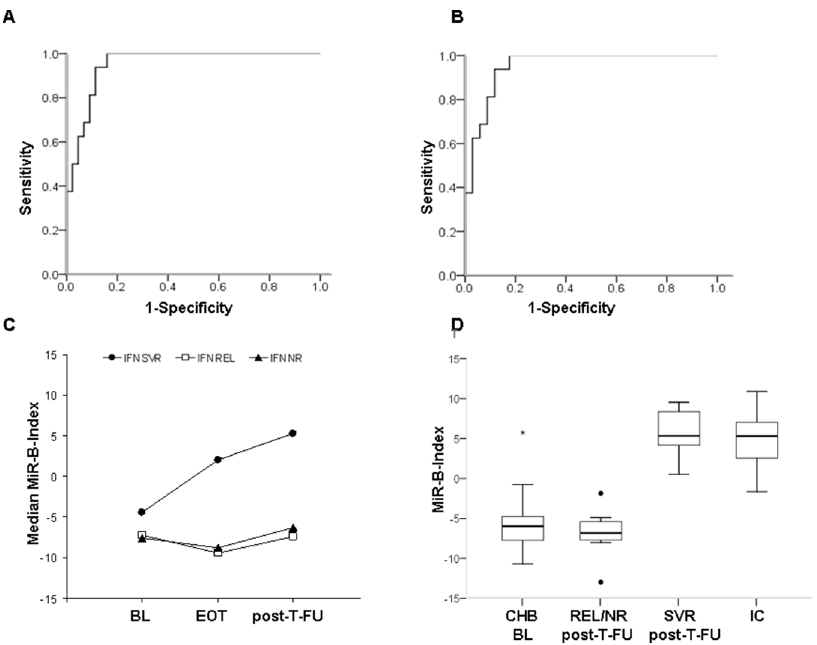
Figure 2. MiR-B-Index in HBV carriers: diagnostic performance to identify inactive carriers (AUROCs), index kinetics in Peg-IFN treated patients by outcome and distribution of the index values by treatment outcome and phase of HBV infection. A) Receiver operating characteristic curve for MiR-B-Index in IC vs patients with chronic hepatitis (HBeAg positive or negative CHB, HBV/HDV chronic hepatitis, ALD1): 0.9520 (95% CI 0.903 to 1.000, p , 0.001); B) ROC for MiR-B-Index in IC vs HBeAg negative CHB (ALD2): 0.954 (95% CI 0.902 to 1.000, p , 0.001; C) Kinetics of MiR-B-Index in 14 patients treated with Peg-IFN: MiR-B-Index values progressively increased in SVR, whereas they showed minor fluctuations in REL/NR (p , 0.001); D) Whisker plot of the MiR-B-Index (y-axis) values in BL CHB patients treated with Peg-IFN (NR, REL and SVR), 24 week post-T-FU of REL/NR and SVR and IC, separately (CHB-BL vs IC p , 0.001; SVR-BL vs SVR PT-FU p , 0.001; REL/NR BL vs REL/NR PT-FU p=0.462; SVR PT-FU vs IC p=0.792).